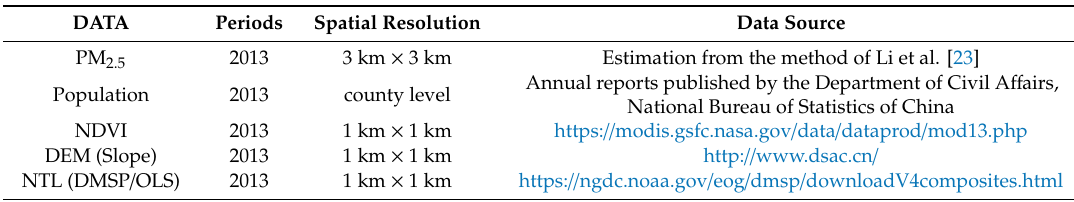
Table 1. Summary of data used in this